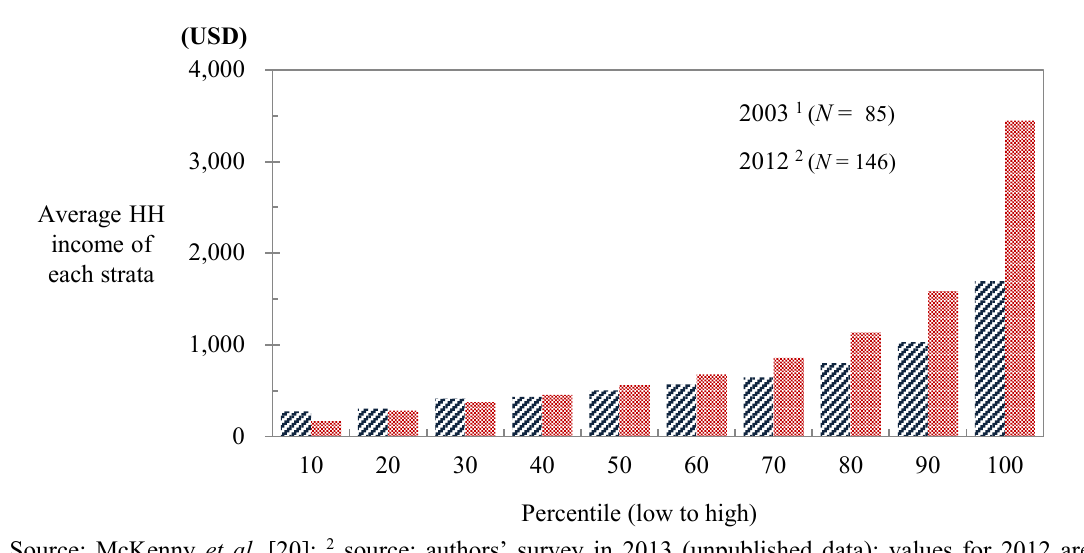
Figure 4. Changes in income distribution between 2003 and 2012 (by